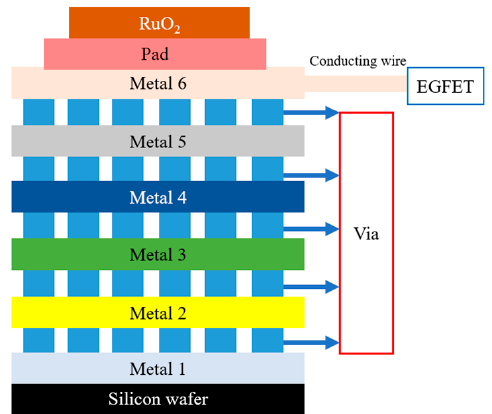
Figure 3. The architecture diagram of OCSW and MOSFET device.